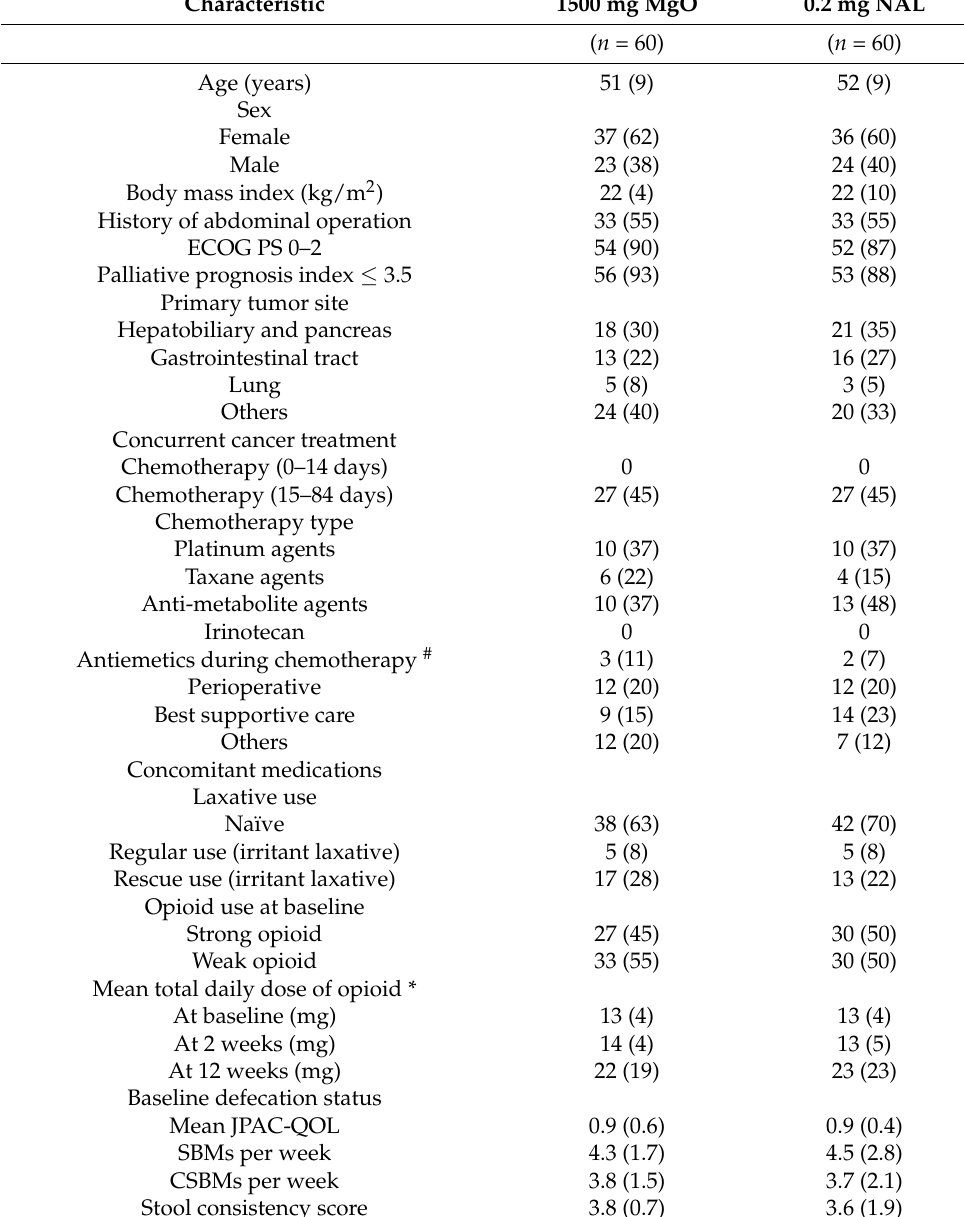
Table 1. Demographic and baseline characteristics of modified intention-to-treat